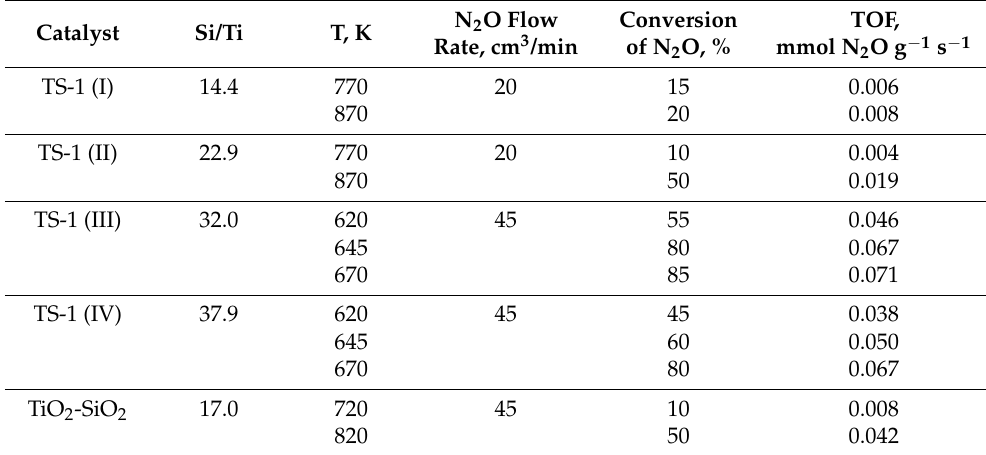
Table 2. Results of catalytic testing of various Ti-systems in the reaction of N 2 O decomposition.